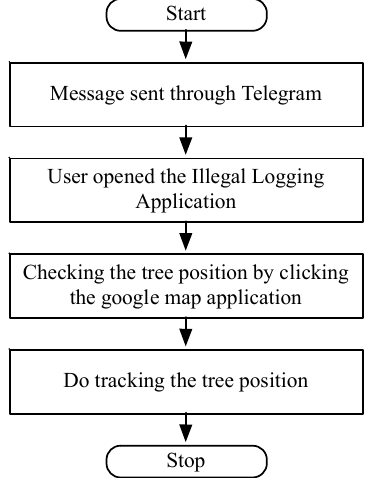
Figure 7. Flowchart of Illegal Logging Application for the User.